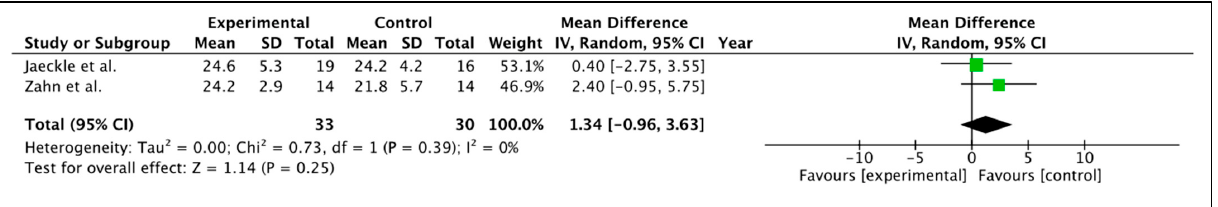
experimental and control groups, and its mean difference and its 95% confidence